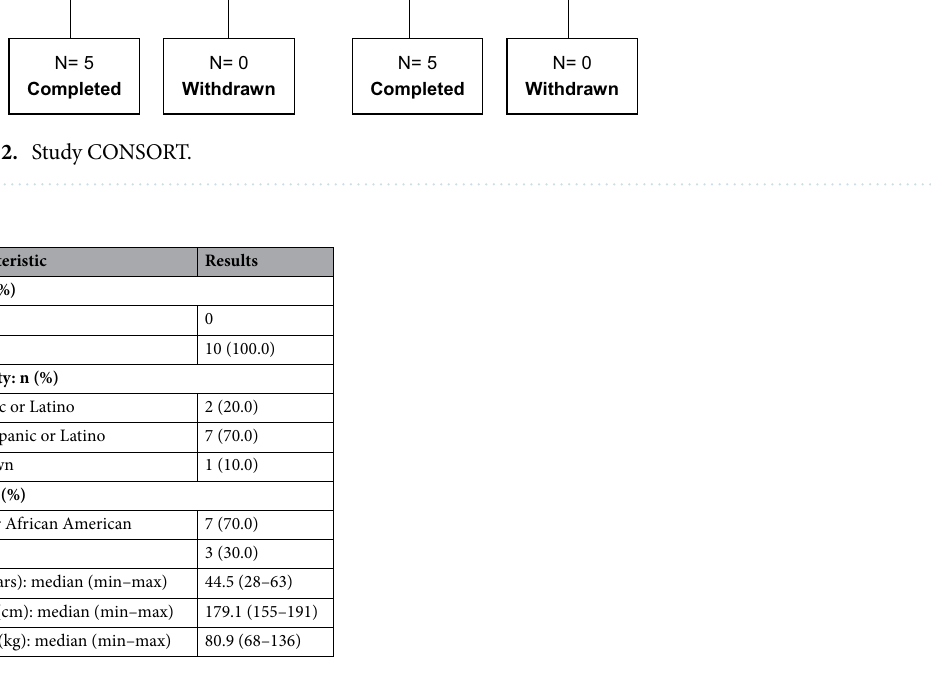
Table 1. Summary of